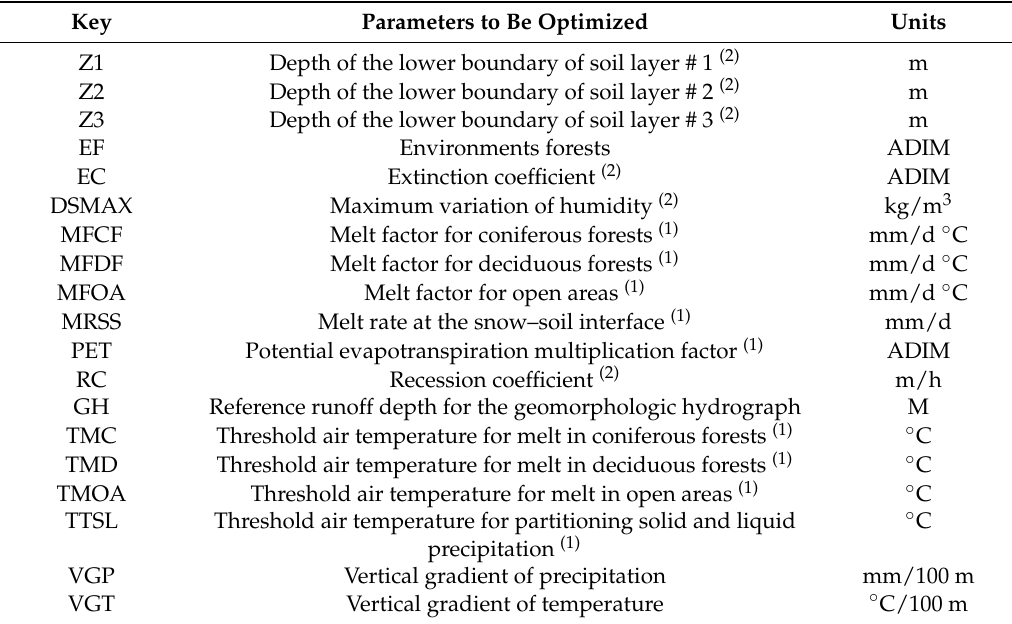
Table 3. Parameters of the distributed hydrological